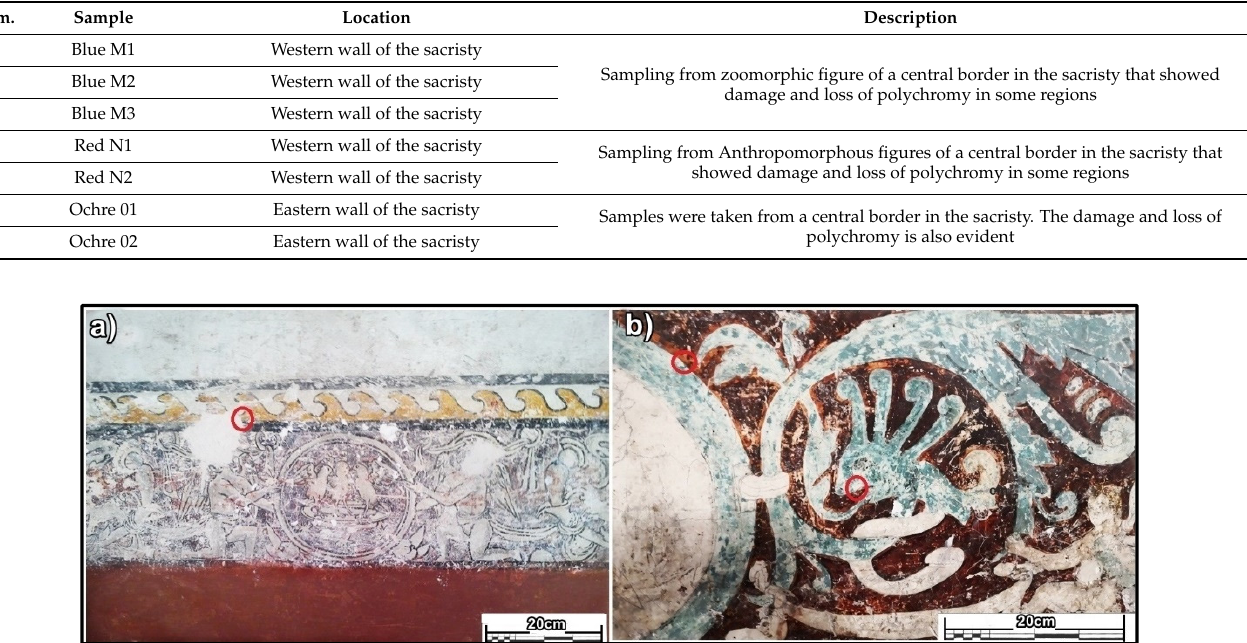
Figure 2. ( a ) General view of the mural painting, the red circle marking the specific area where the ochre sample was taken, and ( b ) general view of the mural painting, the red circle marking the specific area where the blue and red color samples were taken.